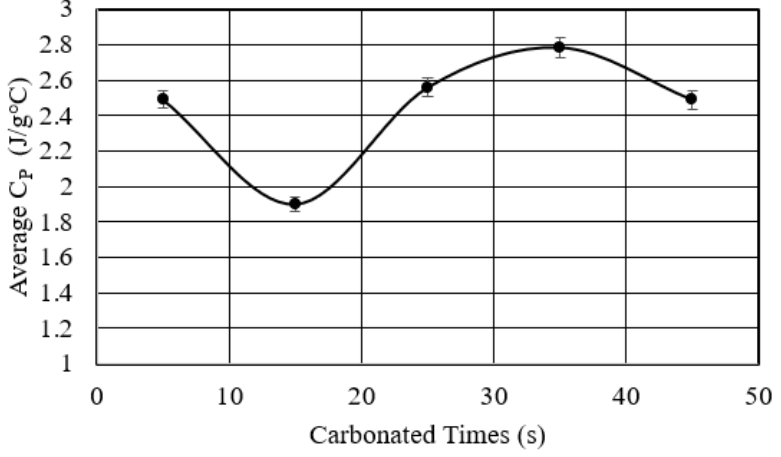
Figure 12. Average specific heat capacity values for carbonated samples. Error bars of ±2%.